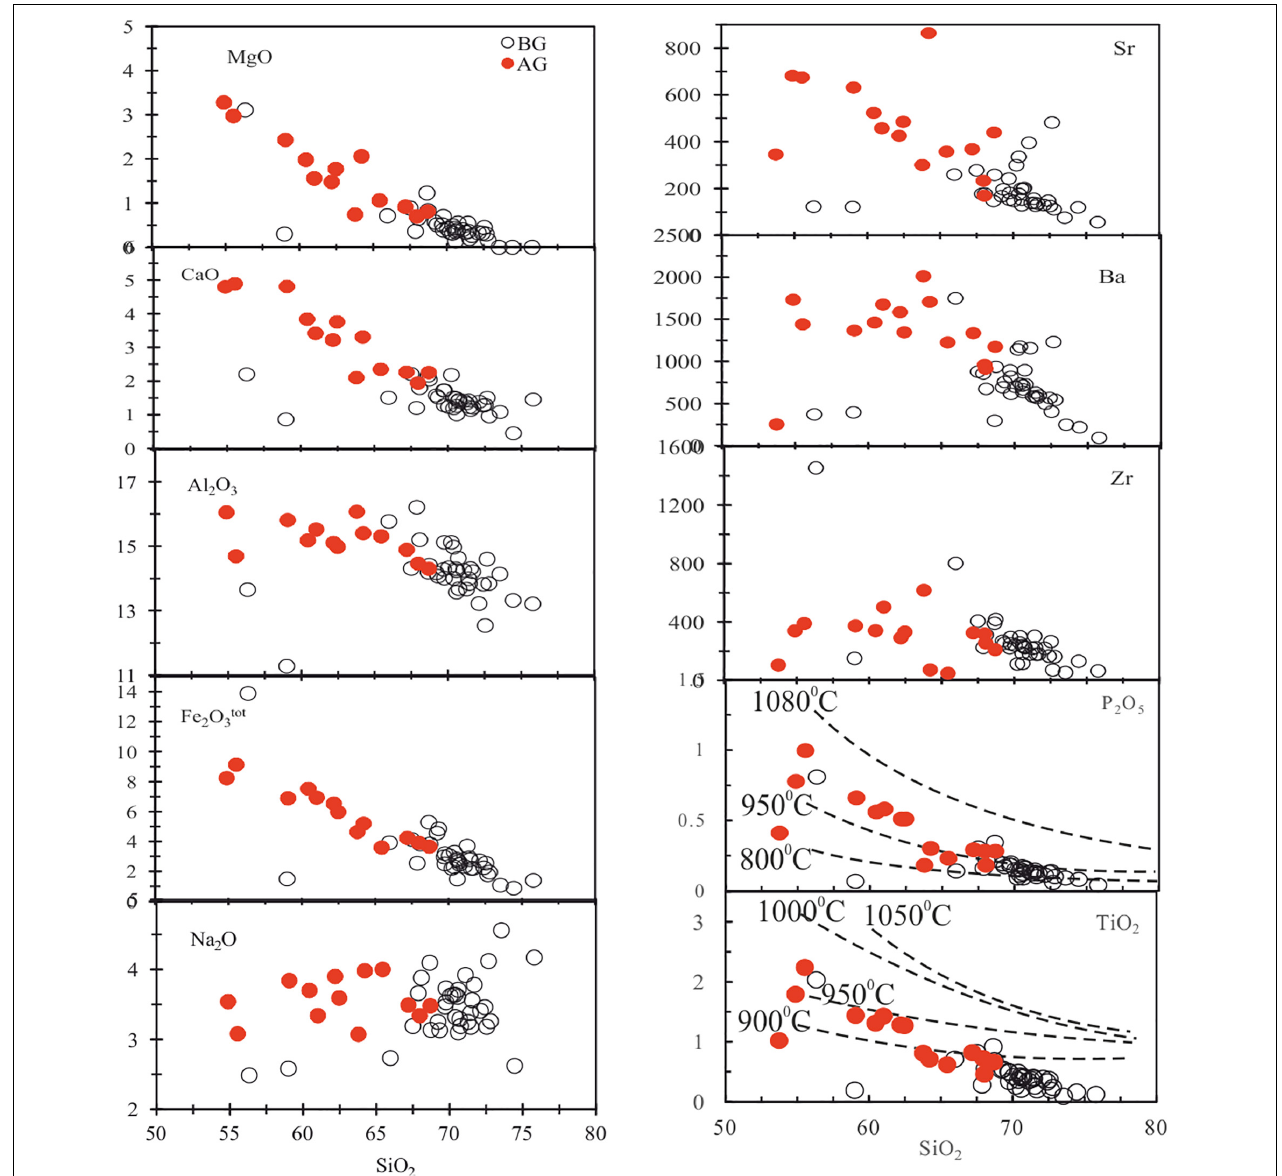
FIGURE 5 | Harker diagrams of selected major and trace elements. P 2 O 5 and TiO 2 are used for evaluating the temperature of crystallization. In P 2 O 5 vs. SiO 2 , the evolution trend is similar to I-type granitoids (Chappell et al., 1998) and mixing melts line (Lee and Bachmann,